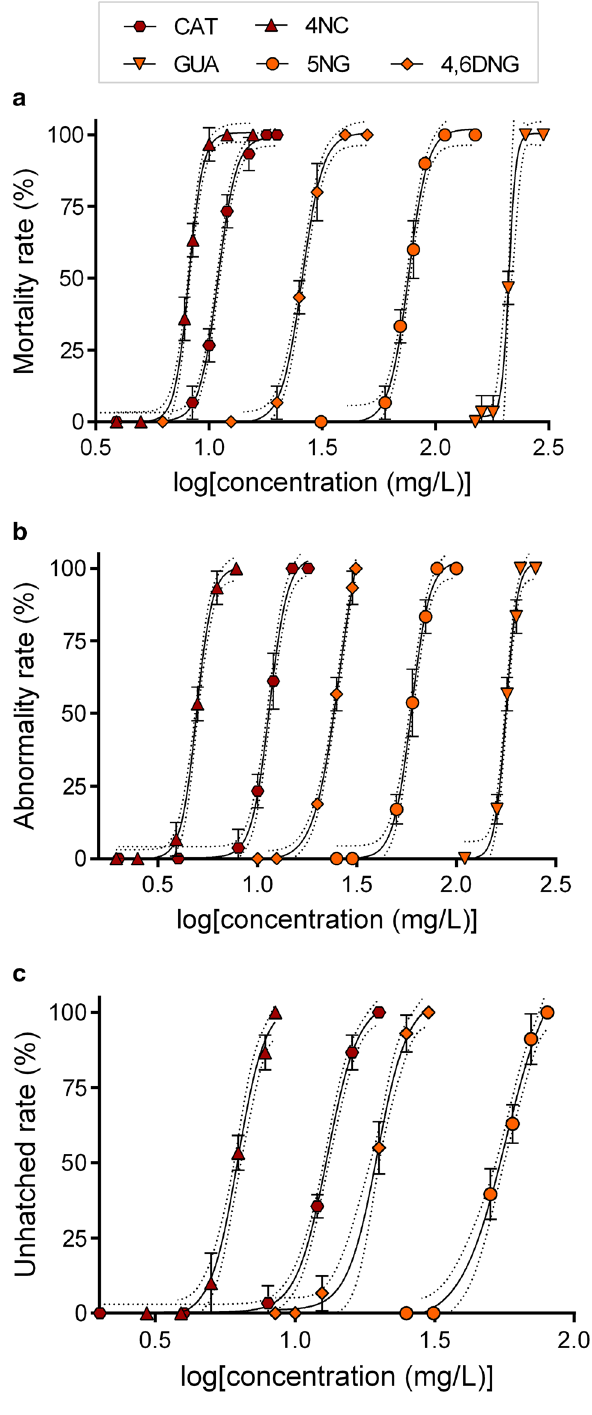
Figure 1. Concentration–response curves used for the calculations of the D. rerio: ( a ) mortality, ( b ) abnormality, and ( c ) unhatching rate after 96 h of exposure to CAT, GUA, 4NC, 5NG, and 4,6DNG. Error bars indicate standard deviations (SD). Dotted lines represent 95% confidence intervals. Dose–response curves were generated using GraphPad Prism software version 6.0 (https ://graph pad-prism .softw are.infor